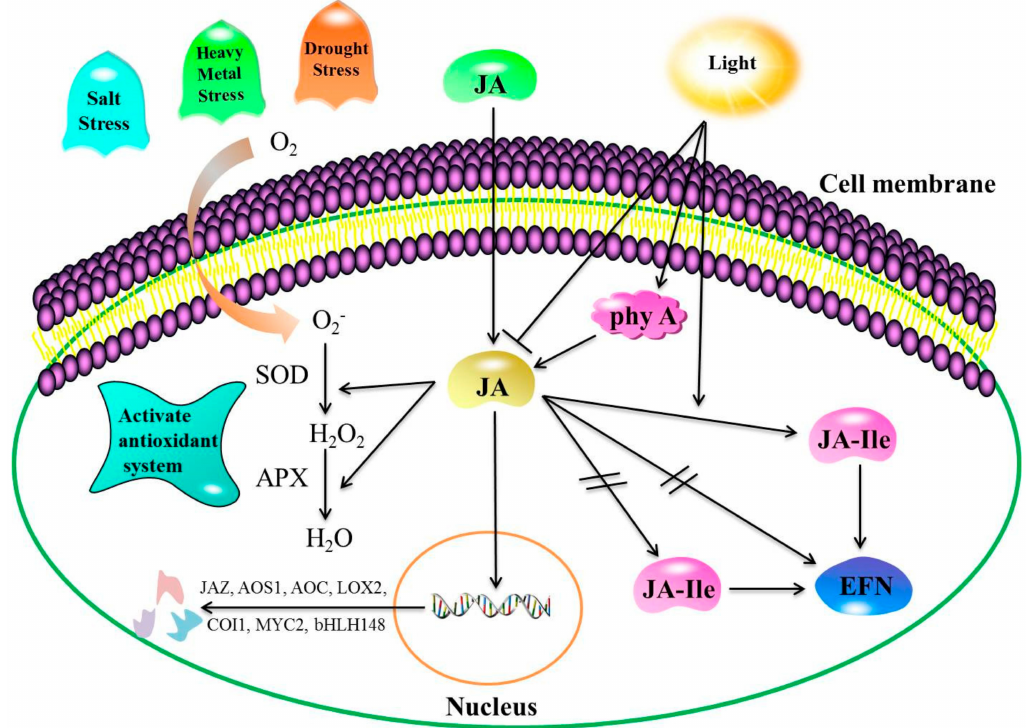
Figure 2. Response mechanism of endogenous JA to abiotic stress. Note: Positive regulatory actions or under light conditions are indicated by arrows and by lines and bars under dark conditions. Double slashes indicate that the process cannot proceed. Salt, drought, or heavy metal stress conditions induce oxidative stress due to elevated reactive oxygen species (ROS) generation levels. The JA produced facilitates stress tolerance by modulating major enzymatic components (SOD and APX) of antioxidant defense systems. In light, the secretion of extra-floral nectar (EFN) is promoted by JA and jasmonate isoleucine conjugate (JA-Ile). Conversely, no light inhibits the secretion of EFN by JA, but not JA-Ile. Far-red (FR) light induces phytochrome A (phyA) and activities of the JA singling pathway. SOD: superoxide dismutase; APX: ascorbate